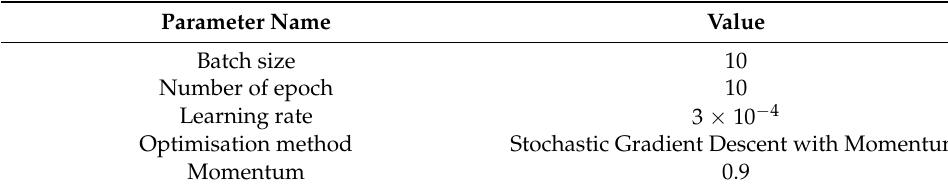
Table 1. Training